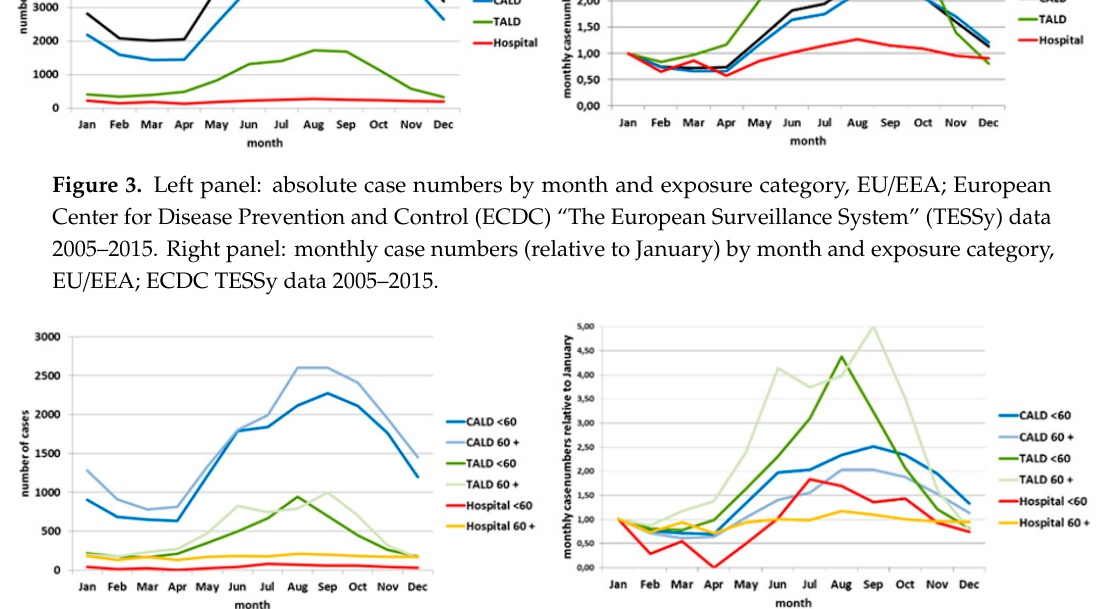
Figure 4. Left panel: absolute case numbers by month, age group and exposure category, EU / EEA; ECDC TESSy data 2005–2015. Right panel: monthly case numbers (relative to January) by month, age group and exposure category, EU / EEA; ECDC TESSy data 2005–2015.